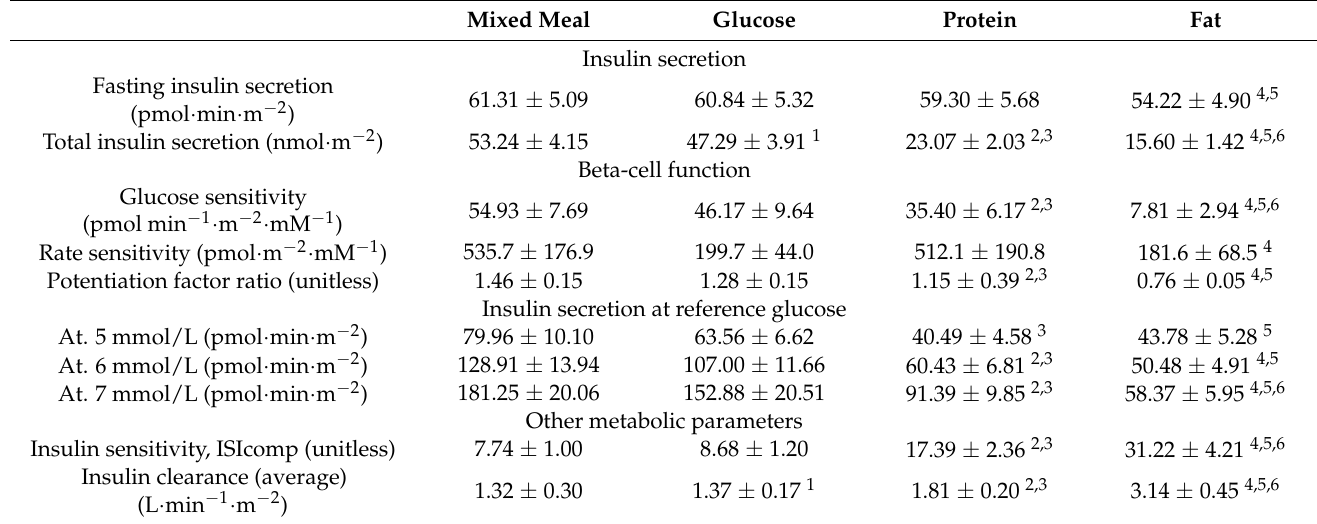
Table 2. Main metabolic parameters after ingestion of a mixed meal or single macronutrients in a cohort of 36 subjects (18 subjects with normal glucose tolerance and 18 subjects with type 2 diabetes). Data are mean ±